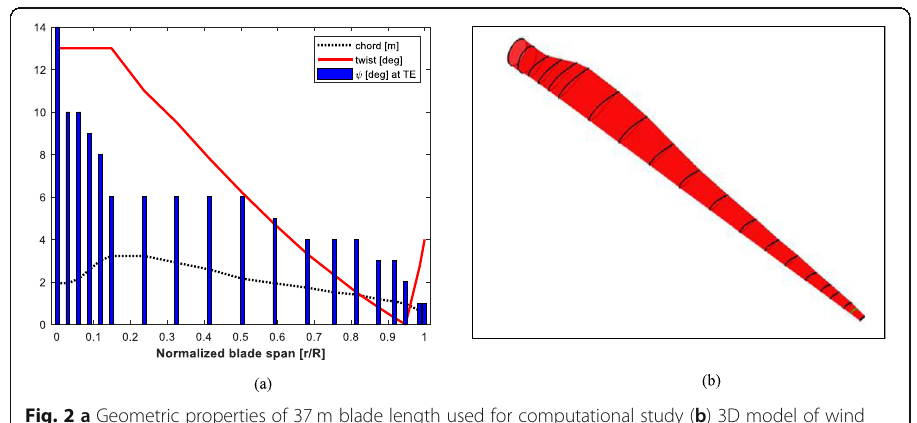
Fig. 2 a Geometric properties of 37 m blade length used for computational study ( b ) 3D model of wind turbine blade developed using NuMAD software (https://energy.sandia.gov/energy/renewable-energy/wind-power/rotor-innovation/numerical-